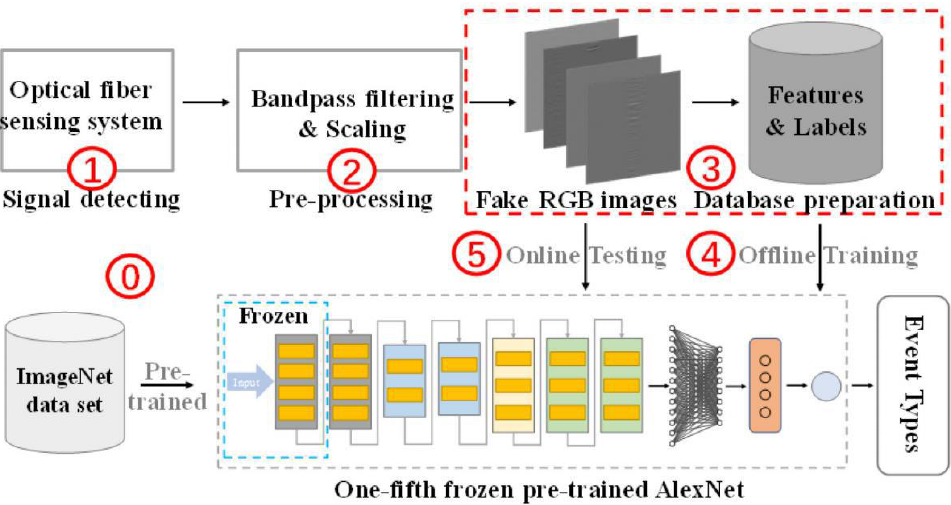
Figure 19. Classification method steps [74].